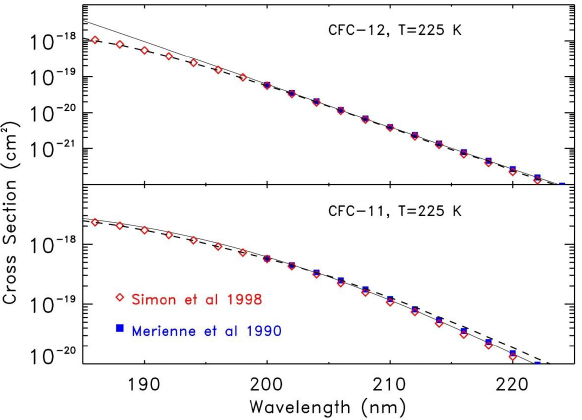
Fig. 1. Absorption cross section measurements interpolated to 225 K from Simon et al. (1988) (red diamonds) and Merienne et al. (1990) (blue squares) for CFC-12 (top) and CFC-11 (bottom). Also plotted are empirical polynomial fits (solid curves) that incorporate the wavelength and temperature dependencies (Sander et al., 2011) along with empirical exponential fits (dashed curves) to temperature-dependent cross sections from DeMore et al. (1997).